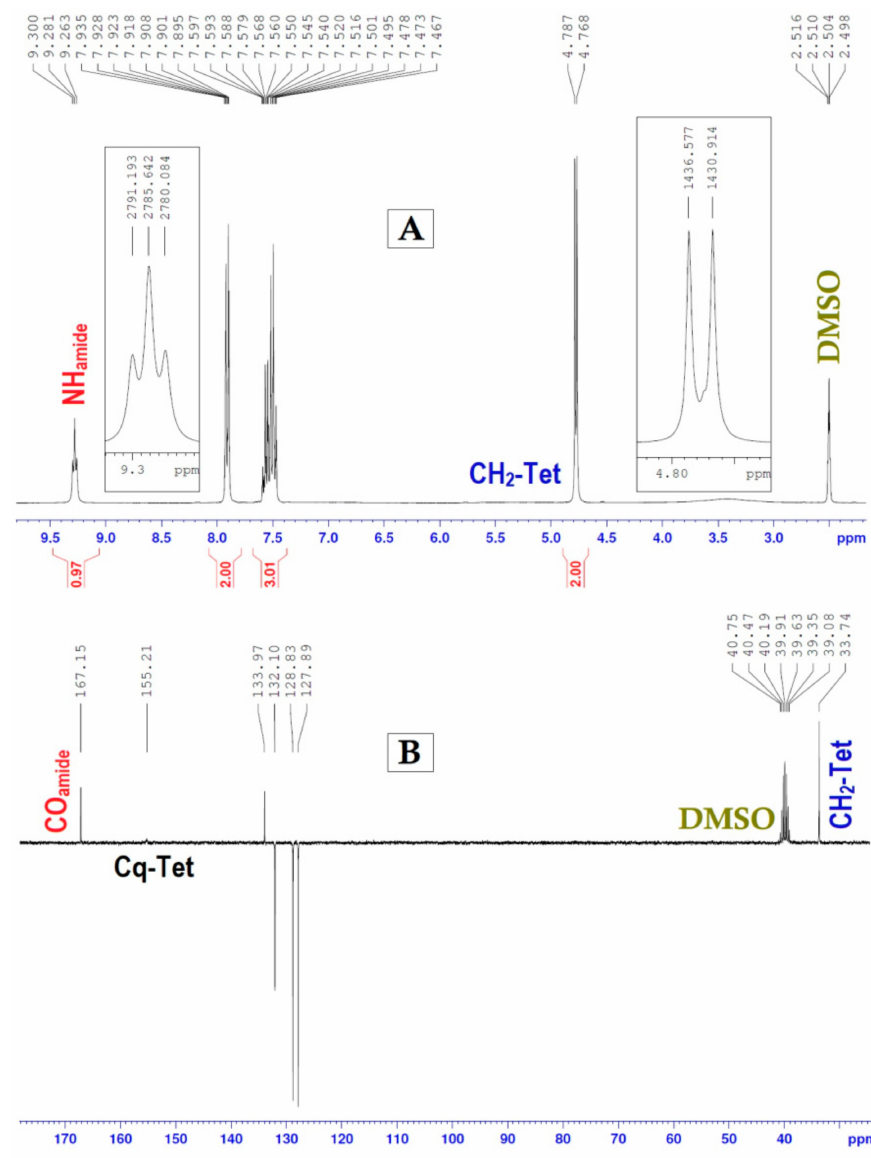
Figure 1. 1 H ( A ) and 13 C NMR ( B ) spectra of